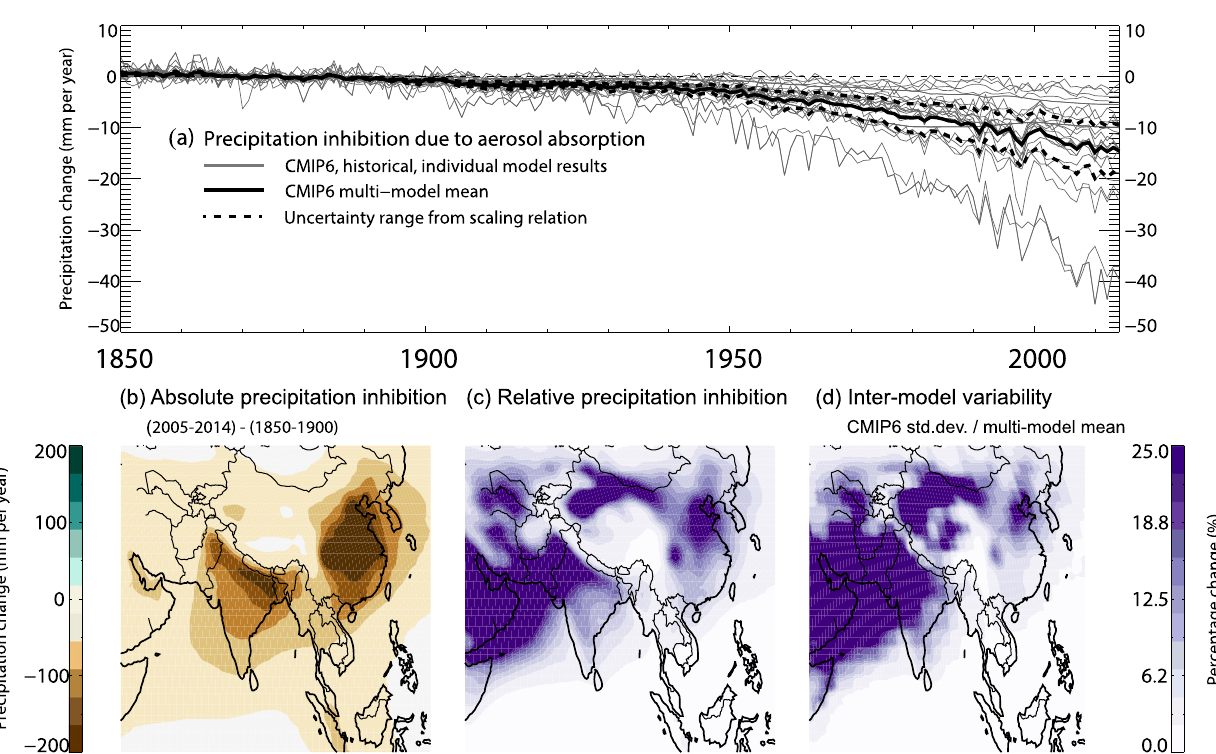
Fig. 3 Diagnosed precipitation inhibition due to aerosol-induced absorption. a Global, annual mean precipitation reduction in CMIP6 models. The uncertainty from the scaling relation (Eq. 1) is shown as dashed lines. b CMIP6 mean precipitation inhibition over South and East Asia. c As b , but relative to the simulated climatological mean precipitation. d Inter-model variability in precipitation inhibition, relative to the climatological